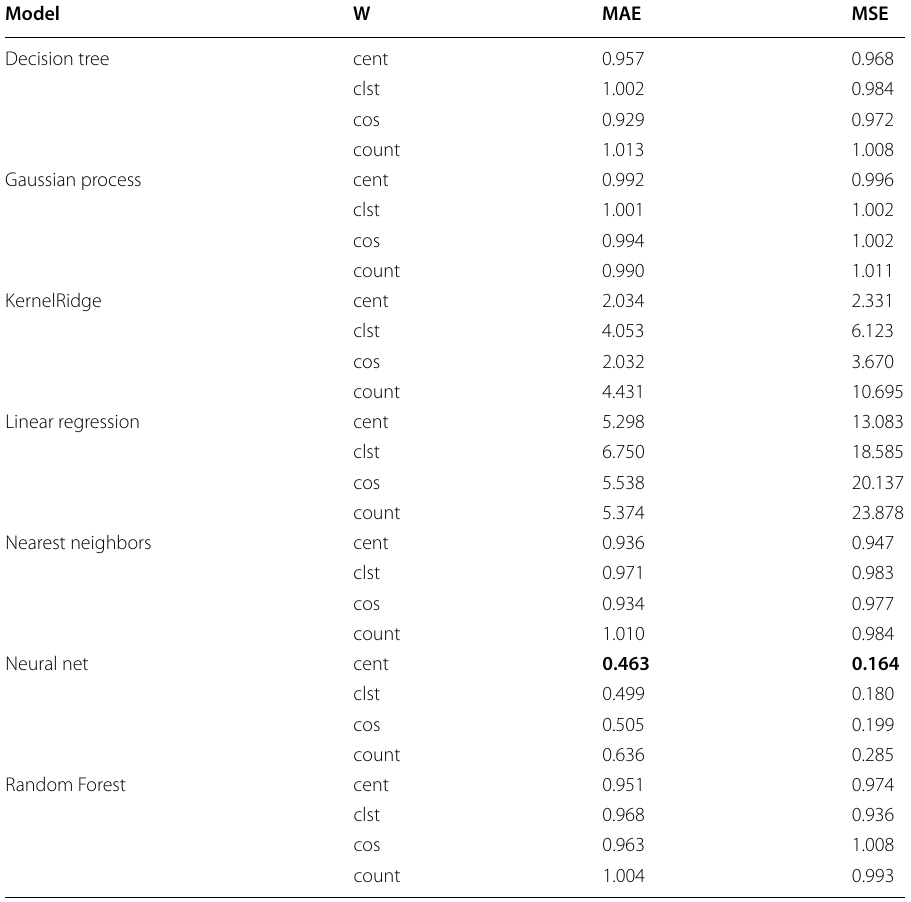
Table 4 Relative errors of prediction